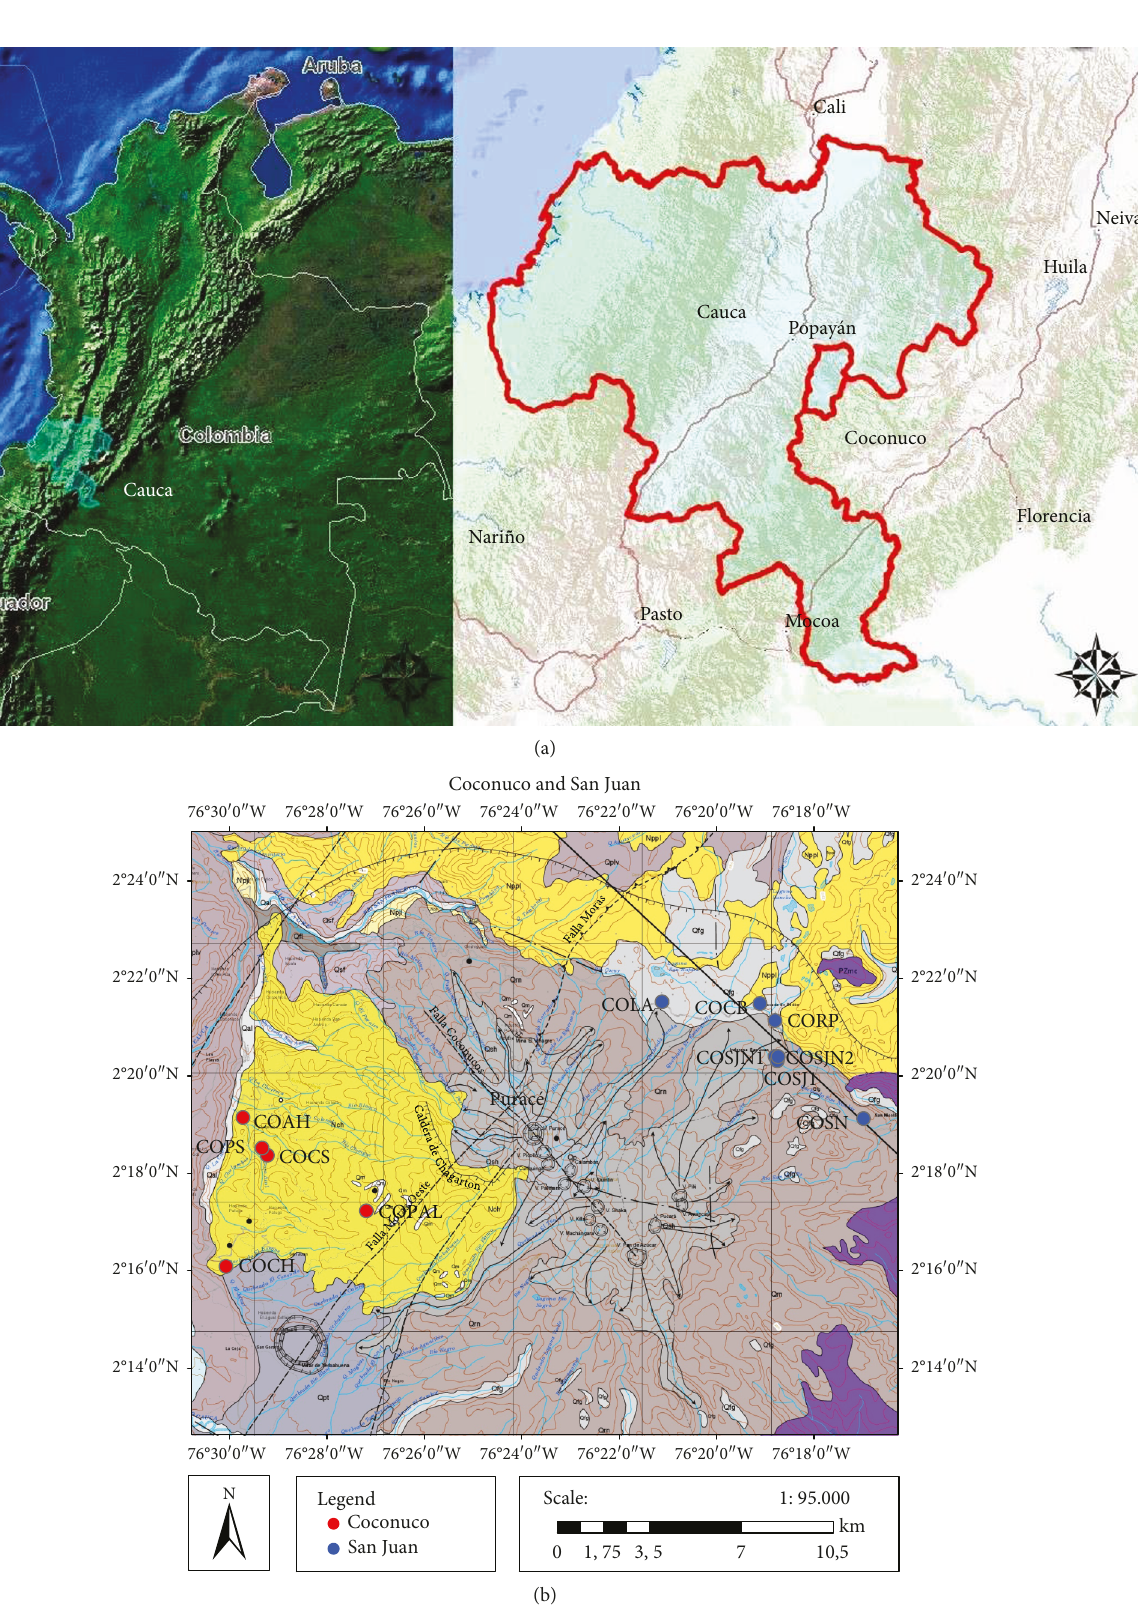
Figure 1: (a) Map of Colombia and Cauca region location and (b) location of monitoring sites of the San Juan sector. O ffi cial map of the Agustin Codazzi Geographic